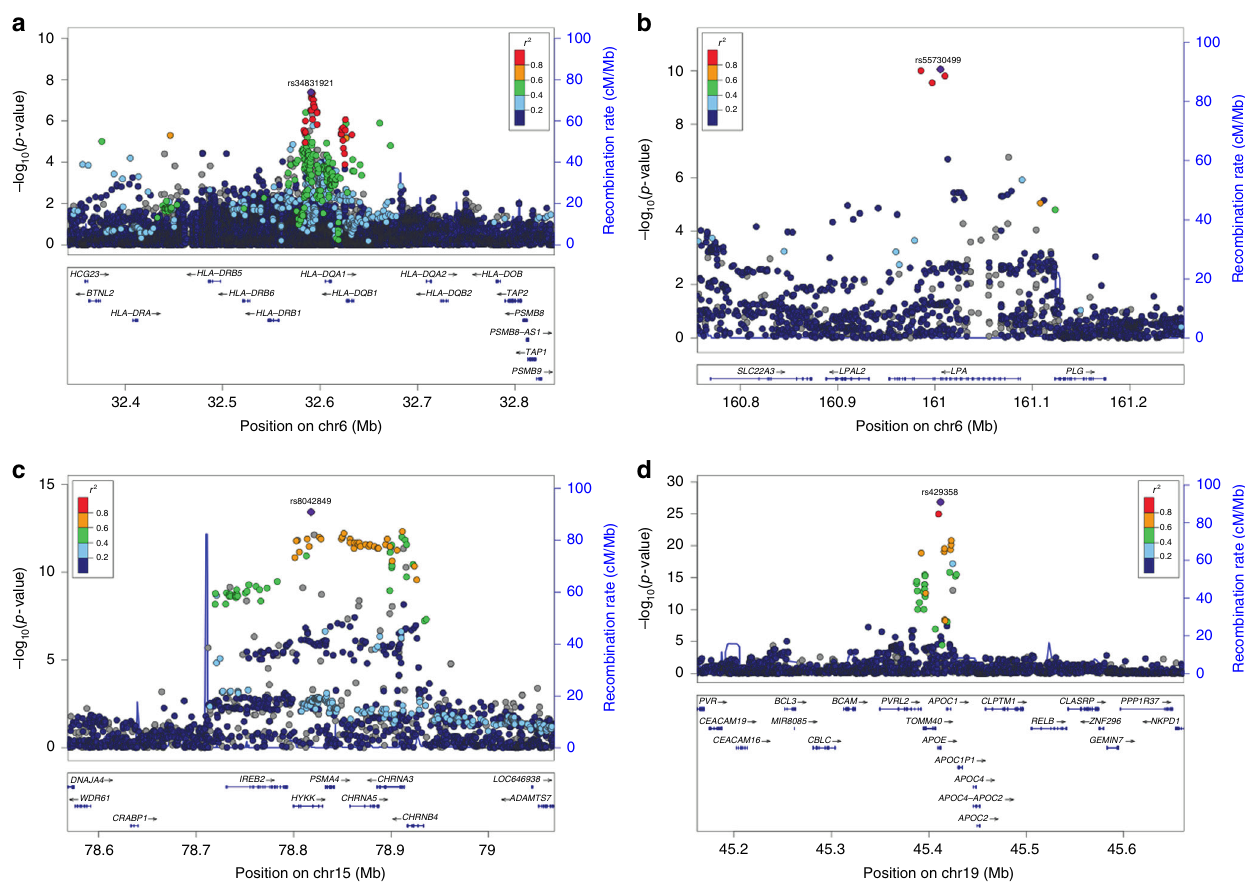
Fig. 2 Locus zoom plots for four genome-wide signi fi cant associations with lifespan. Results from the meta-analysis of subjects of European ancestry analysis, for both parents combined. The displayed p -value corresponds to that of a two-sided test of association between the SNP and parent lifespan under the Cox model. a The rs34831921 variant, at the HLA-DQA1/DRB1 locus, P = 4.18E-08. b The rs55730499 variant, at the LPA locus, P = 8.67E-11. c The rs8042849 variant, at the CHRNA3/5 locus, P = 3.75E-14. d The rs429358 variant, at the APOE locus, P =